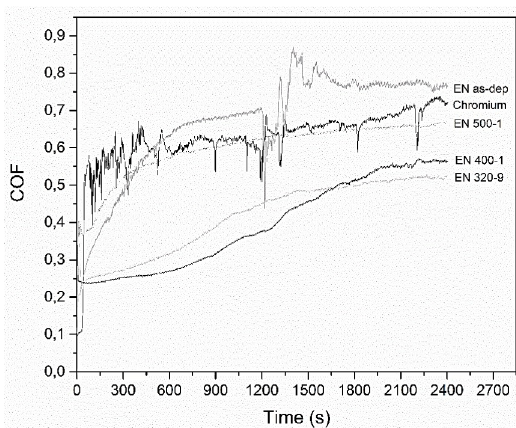
Figure 4. COF curves for all the